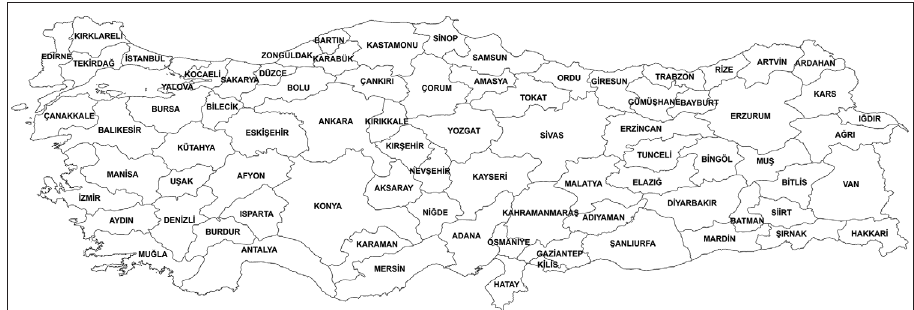
Figure 1. Provinces of